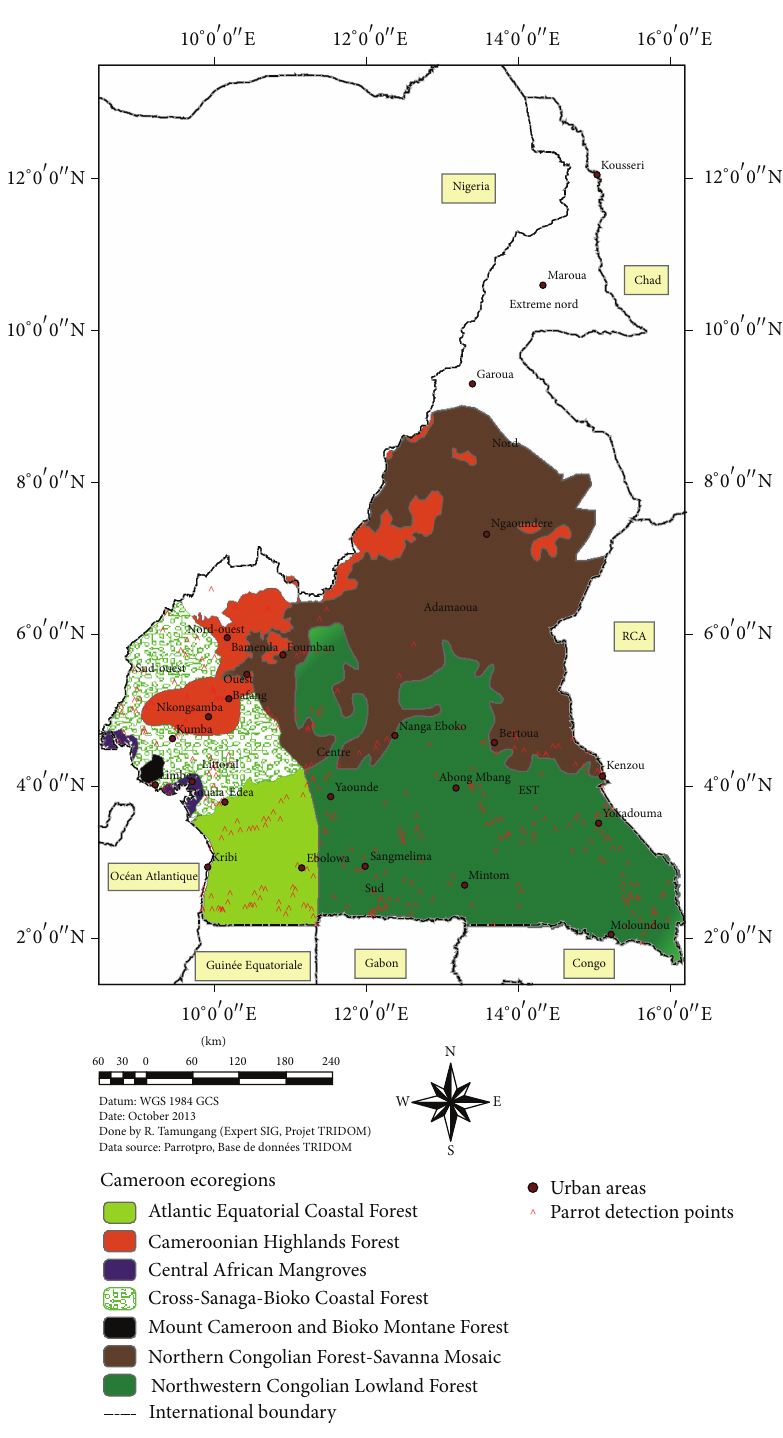
Figure 4: Contemporary distribution of Grey Parrots in ecoregions of Cameroon using parrot detection points.